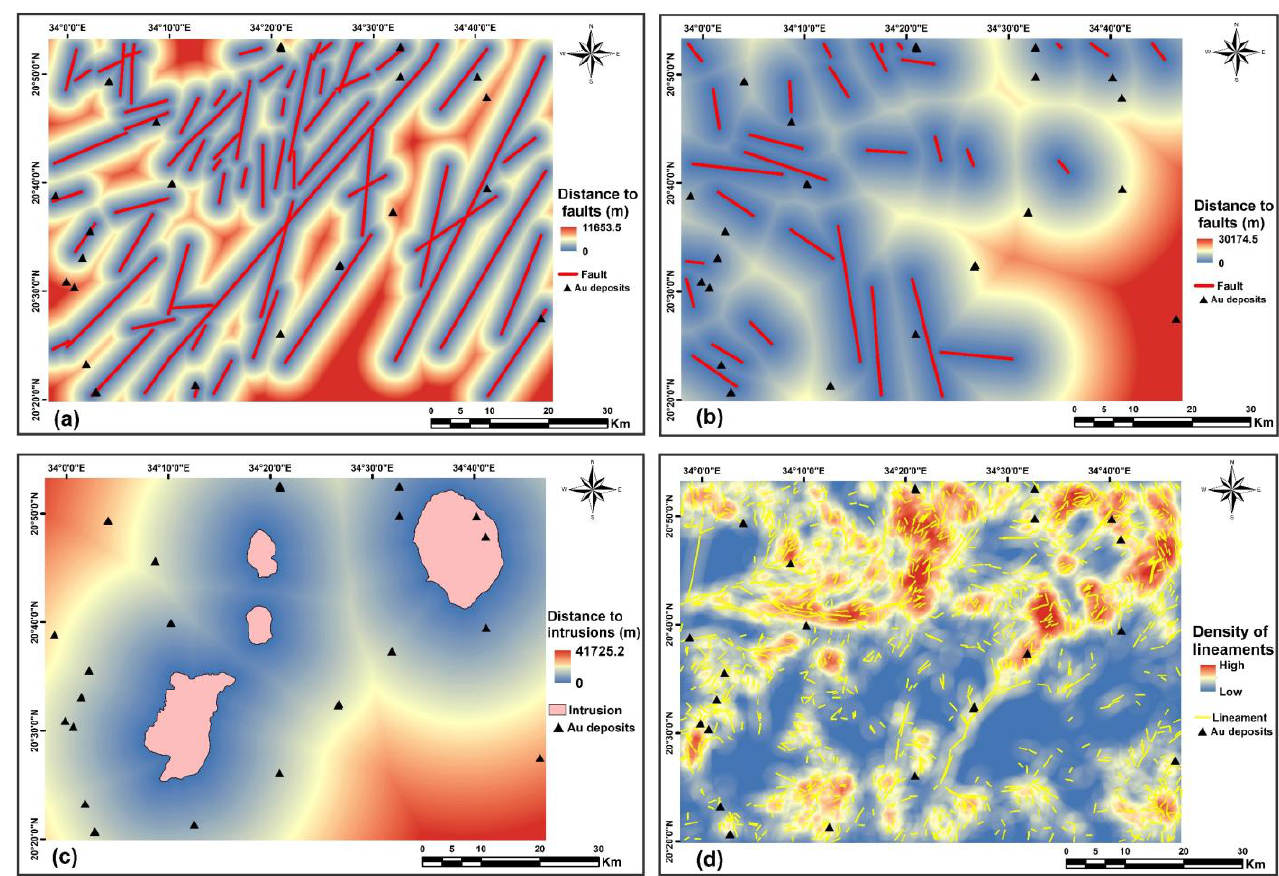
Figure 4. Geological evidential features of the study area used as predictor variables: ( a ) Proximity to NE-SW faults; ( b ) proximity to NW-SE faults; ( c ) proximity to intrusions; ( d ) density of linea- ments.